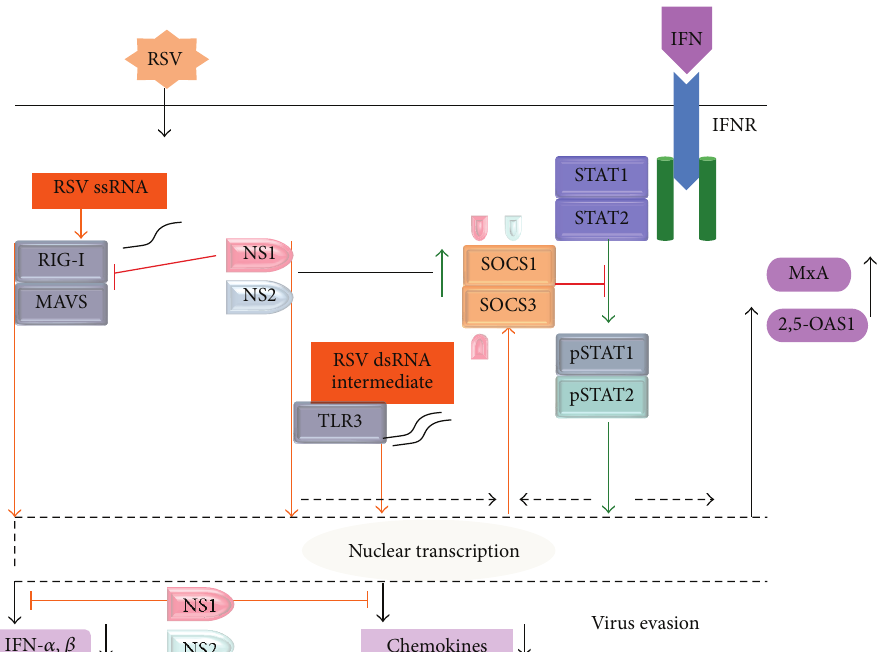
Figure 6: Model of RSV NS proteins activated SOCS1 and SOCS3 independent of endogenous IFN signaling. RSV replication and transcriptionreleasesNS1andNS2whichupregulateSOCS1andSOCS3expressioninhibitendogenousIFN-inducedproductsandexogenous IFN-inducible signaling. NS1 induced SOCS1 and SOCS3 expression, while NS2 only induced SOCS1. Albeit both NS and type I IFN upregulate SOCS1 and SOCS3, NS suppressed the IFN-induced genes as well as the TLR3-dependent chemokines